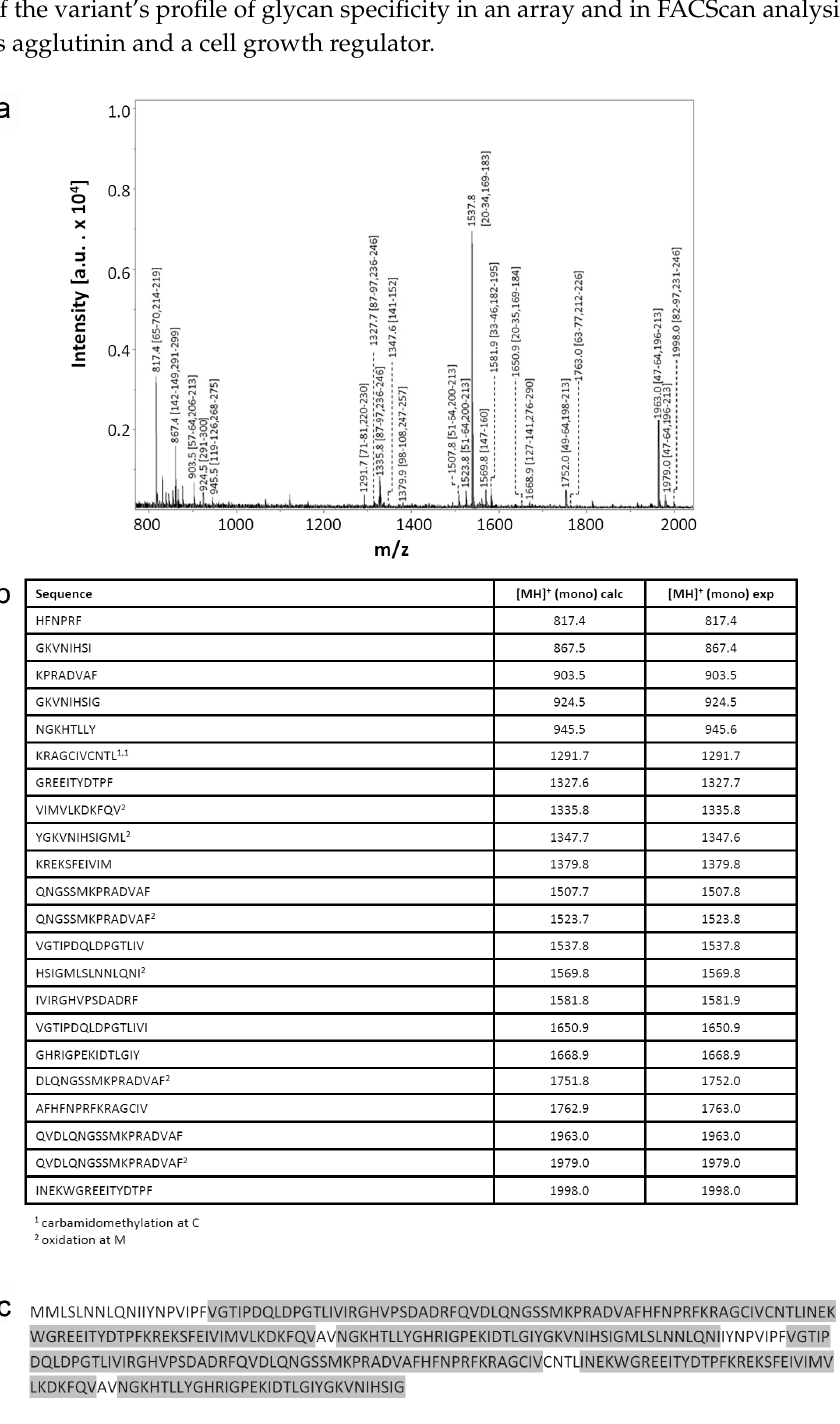
Figure 4. Mass spectrometric fingerprinting of peptides obtained by treatment of Gal-8 (NN) with chymotrypsin. ( a ) The annotated spectrum, ( b ) the list of detected peptides with their calculated (calc) and experimentally (exp) measured mass values and ( c ) the sequence coverage are shown.